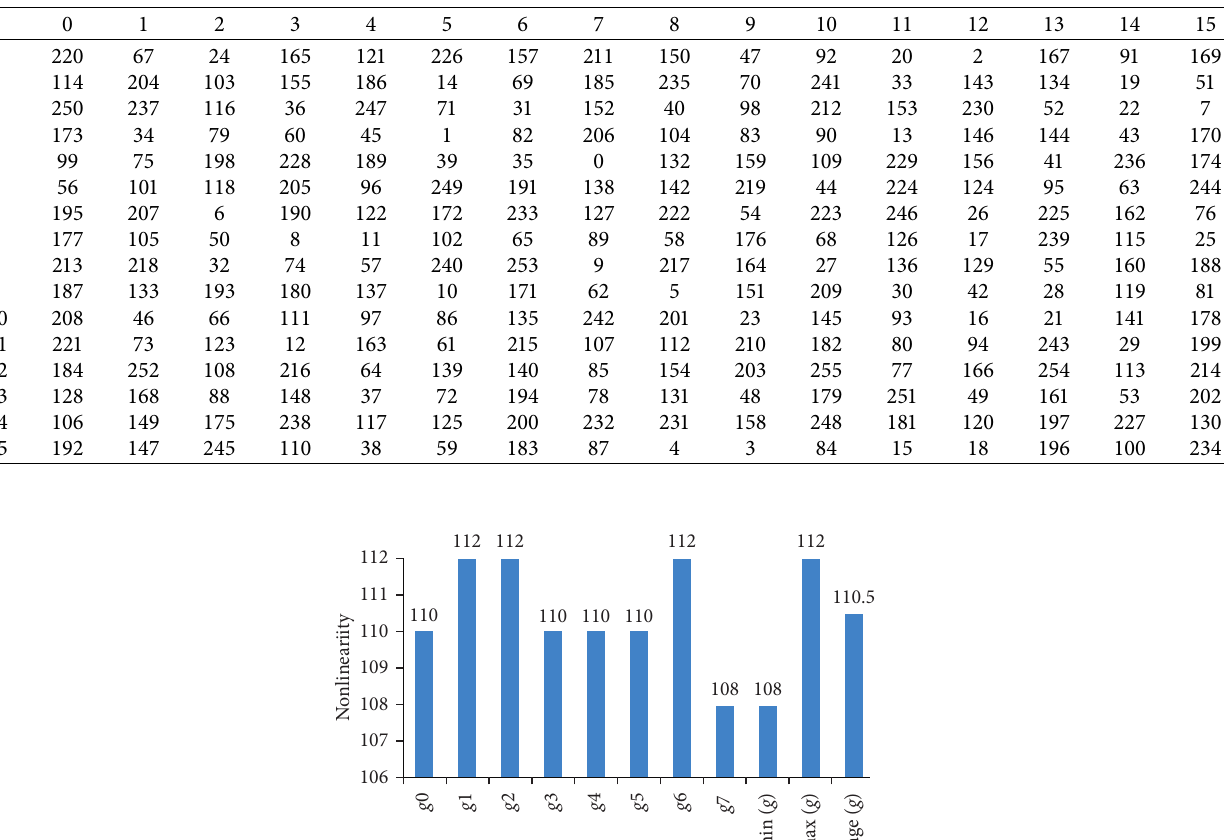
Table 3: Proposed S-box after phase-3.